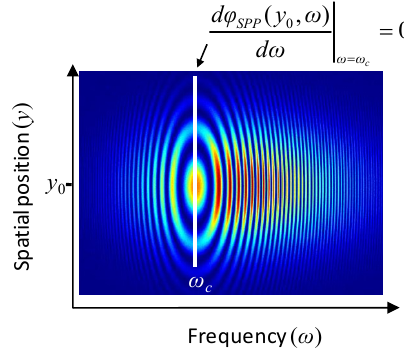
Figure 10. A typical example of spectrally and spatially resolved interferograms with the stationary phase